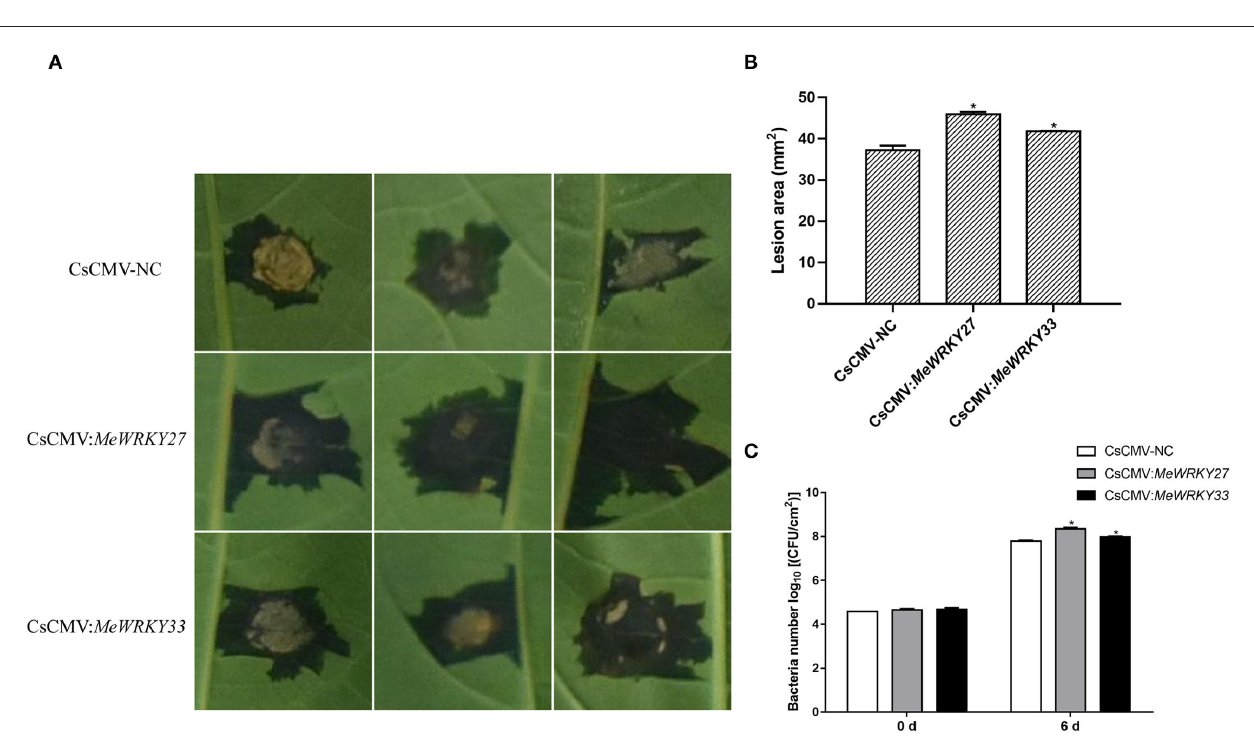
FIGURE 8 | Enhanced susceptibility of MeWRKY27 or 33 -silenced cassava leaves to Xam infection. (A) Disease symptoms on MeWRKY27 or 33 -silenced cassava leaves at 6 days after inoculation with Xam CHN11 (1 × 10 8 CFU ml − 1 ). (B) Lesion areas caused by Xam CHN11. (C) Bacterial growth in Xam -infected leaves (1 × 10 7 CFU ml − 1 ). Asterisks indicate a significant difference ( p < 0.05) between control and